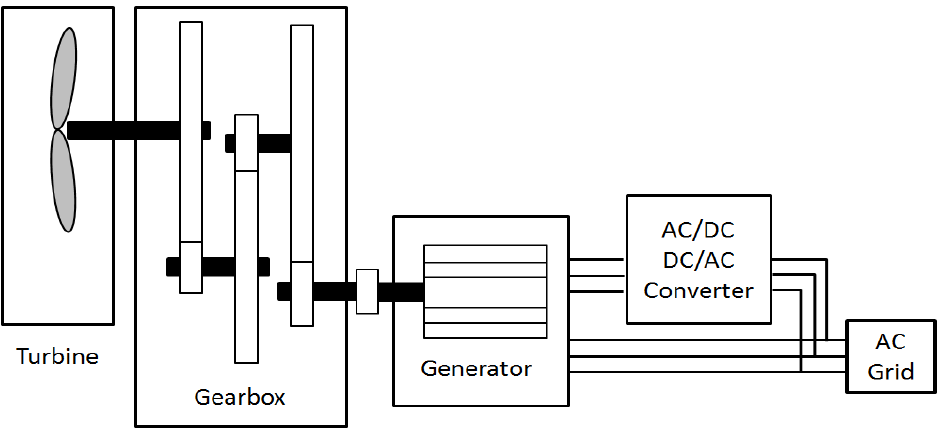
Figure 1. The DFIG architecture for the wind turbine.